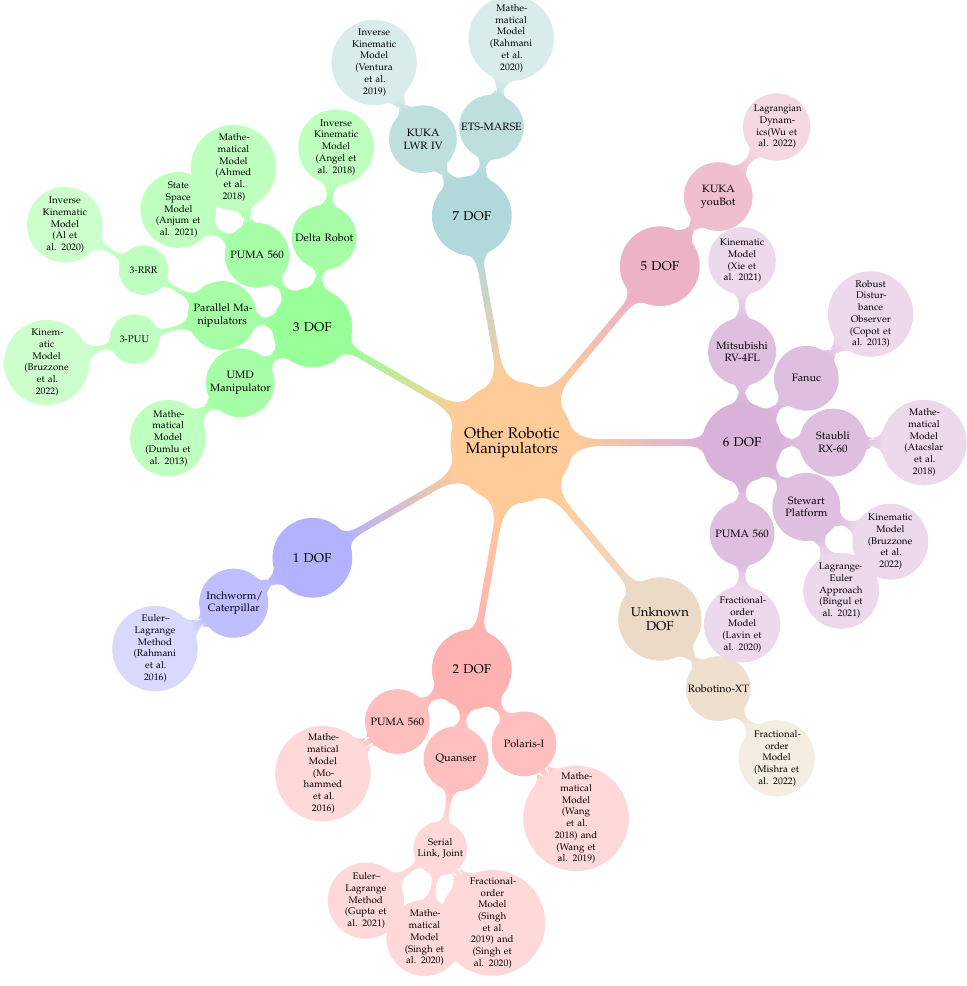
Figure 9. Modelling strategies used for various lower and higher DOF robotic manipulators